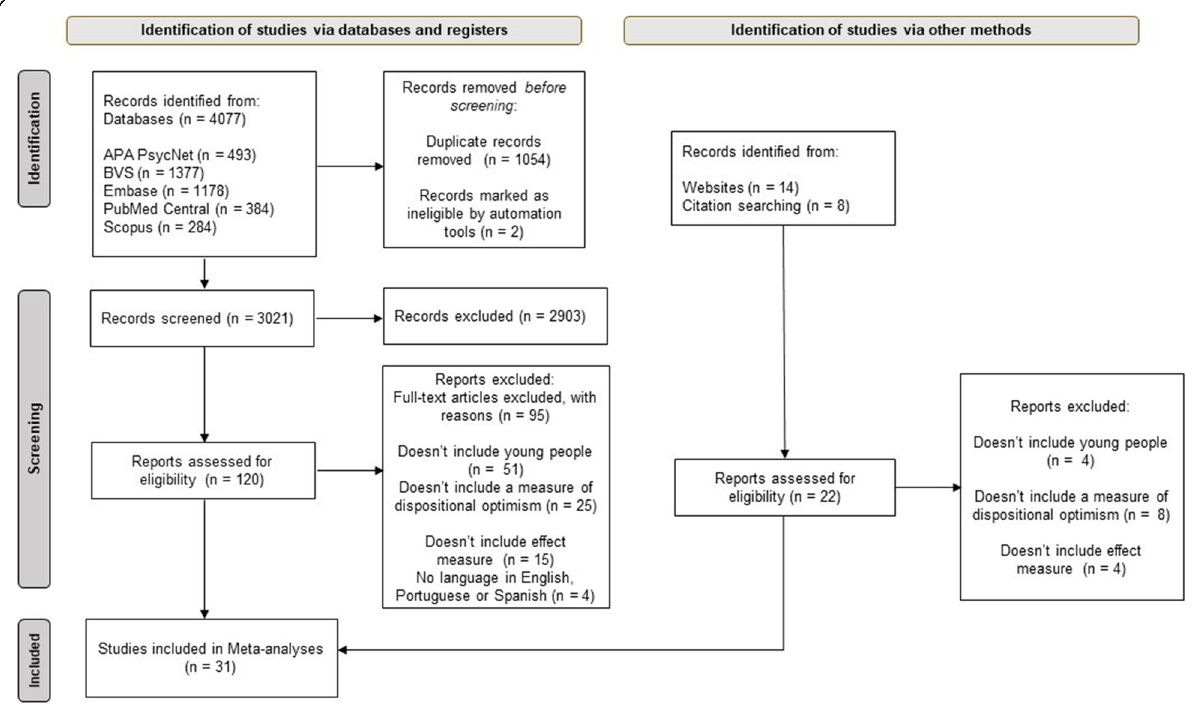
Fig. 1 PRISMA flow chart. Detailed description of the study selection process through the different phases of a systematic review. The number of records identified, included and excluded, as well as the reasons for exclusions are